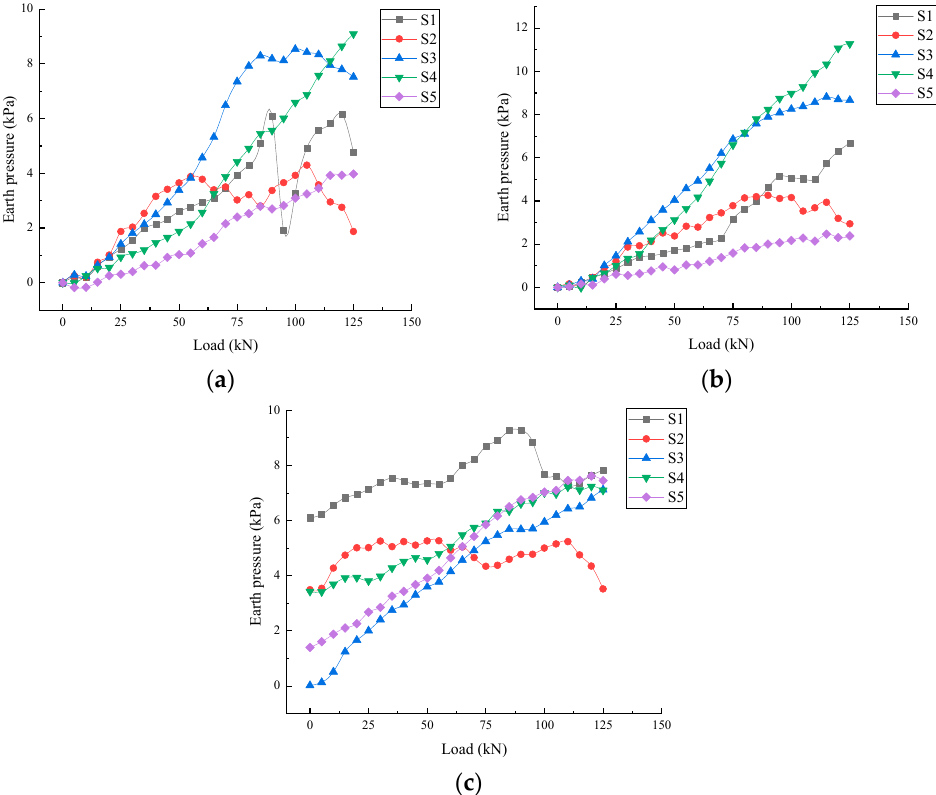
Figure 9. Variation of horizontal earth pressure at measured points along the slope with the slope top load ( a ) Test G1 plain soil slope. ( b ) Test G2 bamboo-rooted slope. ( c ) Test G3 rainfall bamboo- rooted slope.